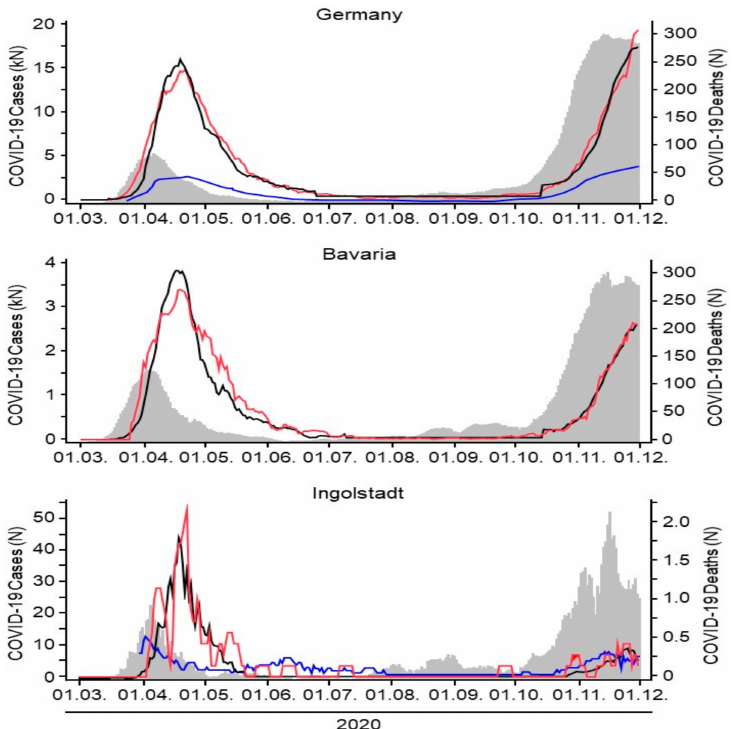
Figure 3. Time series analyses performed on the temporal incidence of SARS-CoV-2 infections (grey area, left scale) and the incidence of COVID-19-associated deaths (red line, right scale). The predic- tion model (black line, right scale) for COVID-19-associated deaths in Germany, Bavaria, and the city of Ingolstadt. Blue lines: number of patients in Germany and Ingolstadt treated per day on an intensive care